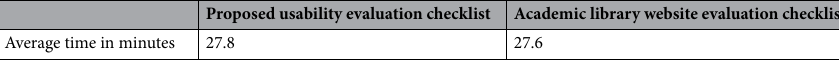
Table 8. Efficiency analysis of both checklists.